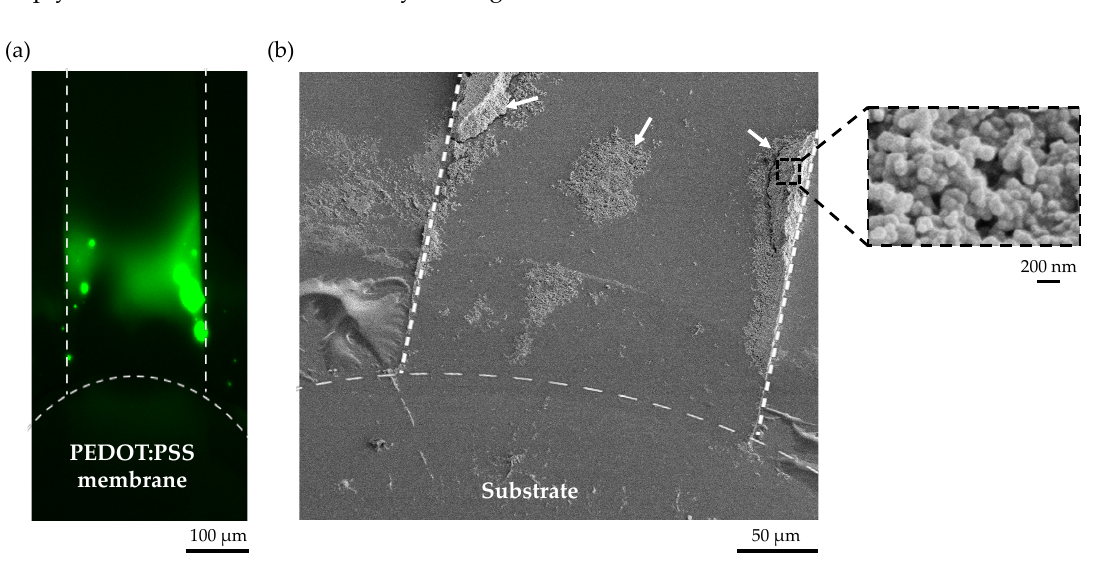
Figure 4. Captured extracellular vesicles on a superaldehyde glass based on surface binding after preconcentration at 45 V/cm for 30 min. ( a ) Electrokinetic preconcentration of extracellular vesicles in the microchannel, ( b ) The two white arrows and the black dotted square in the SEM image indicated areas of captured extracellular vesicles on a superaldehyde substrate after preconcentration. The SEM inset shows aggregated EVs with a size of <~200